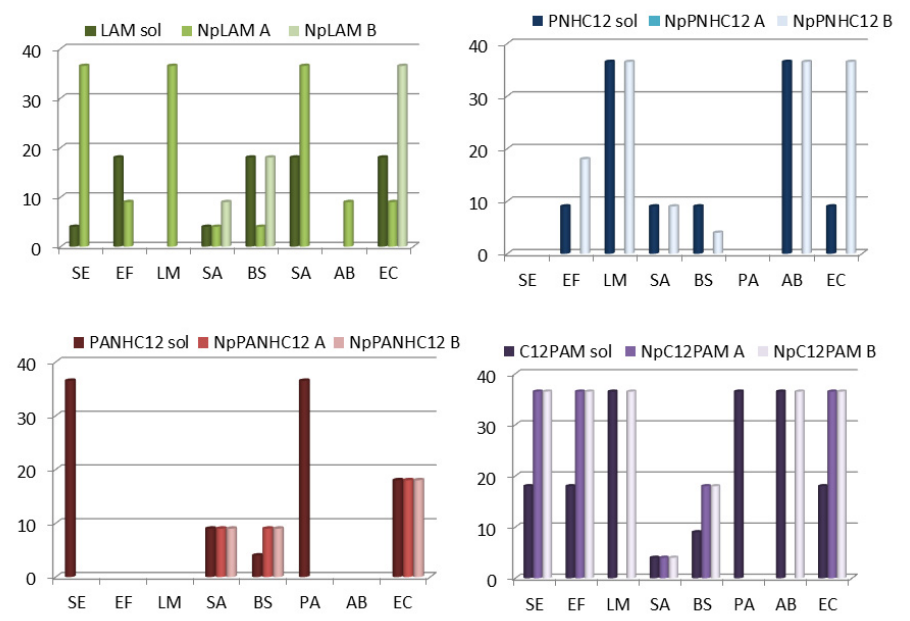
Figure 11. MIC values (µg/mL) for LAM, PNHC 12 , PANHC 12 and C 12 PAM solutions and loaded-zein